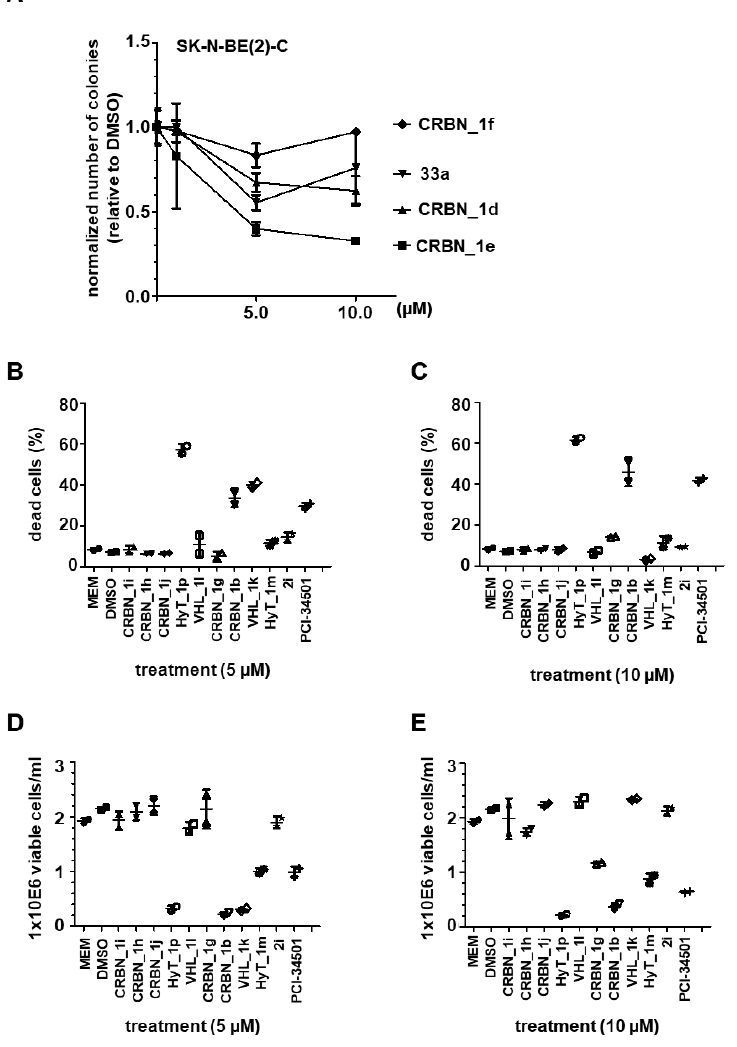
Figure 5. ( A ) Neuroblastoma SK-N-BE(2)-C cells; Colony Assay, 10 days (compound treatment within first 96 h). Stained with crystal violet and quantified with ImageJ. ( B , C ) Trypan Blue assay for detection of dead cells. Neuroblastoma IMR-32 cells were either treated with 5 µM ( B ) or 10 µM ( C ). ( D , E ) Cell proliferation assessed via counting of viable cells. IMR-32 cells were either treated with 5 µM ( D ) or 10 µM ( E ) PROTACs. HDAC8i PCI-34501 served as a positive control, untreated (MEM) and solvent (DMSO) treated cells served as negative controls.